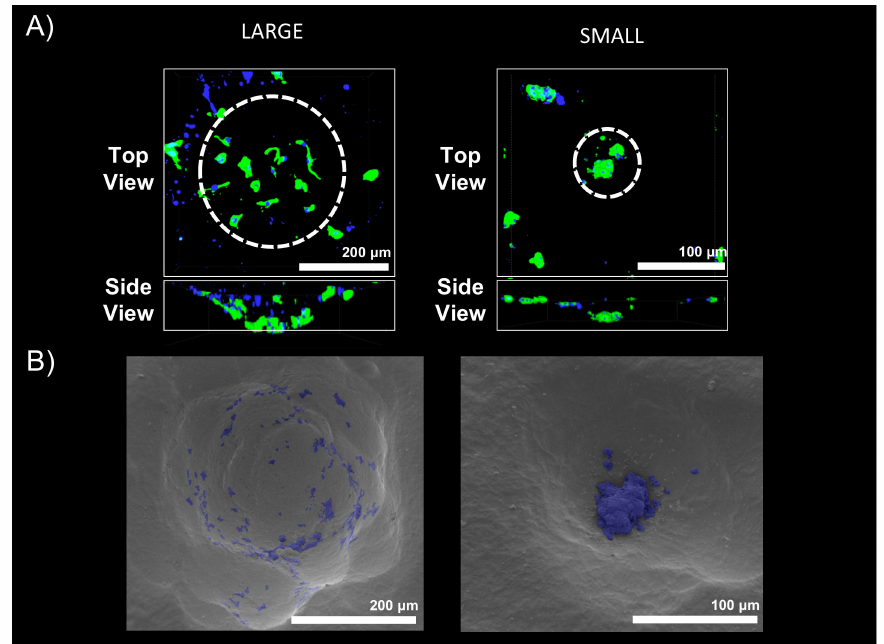
Figure 7. Cells cultured in macropore-mimetic hemispheres cast from PDMS, visualized by confocal laser microscopy (green: actin, blue: DAPI/nucleus, ( A )) and scanning electron microscopy (SEM, ( B )) Circular dashed line represents macropore